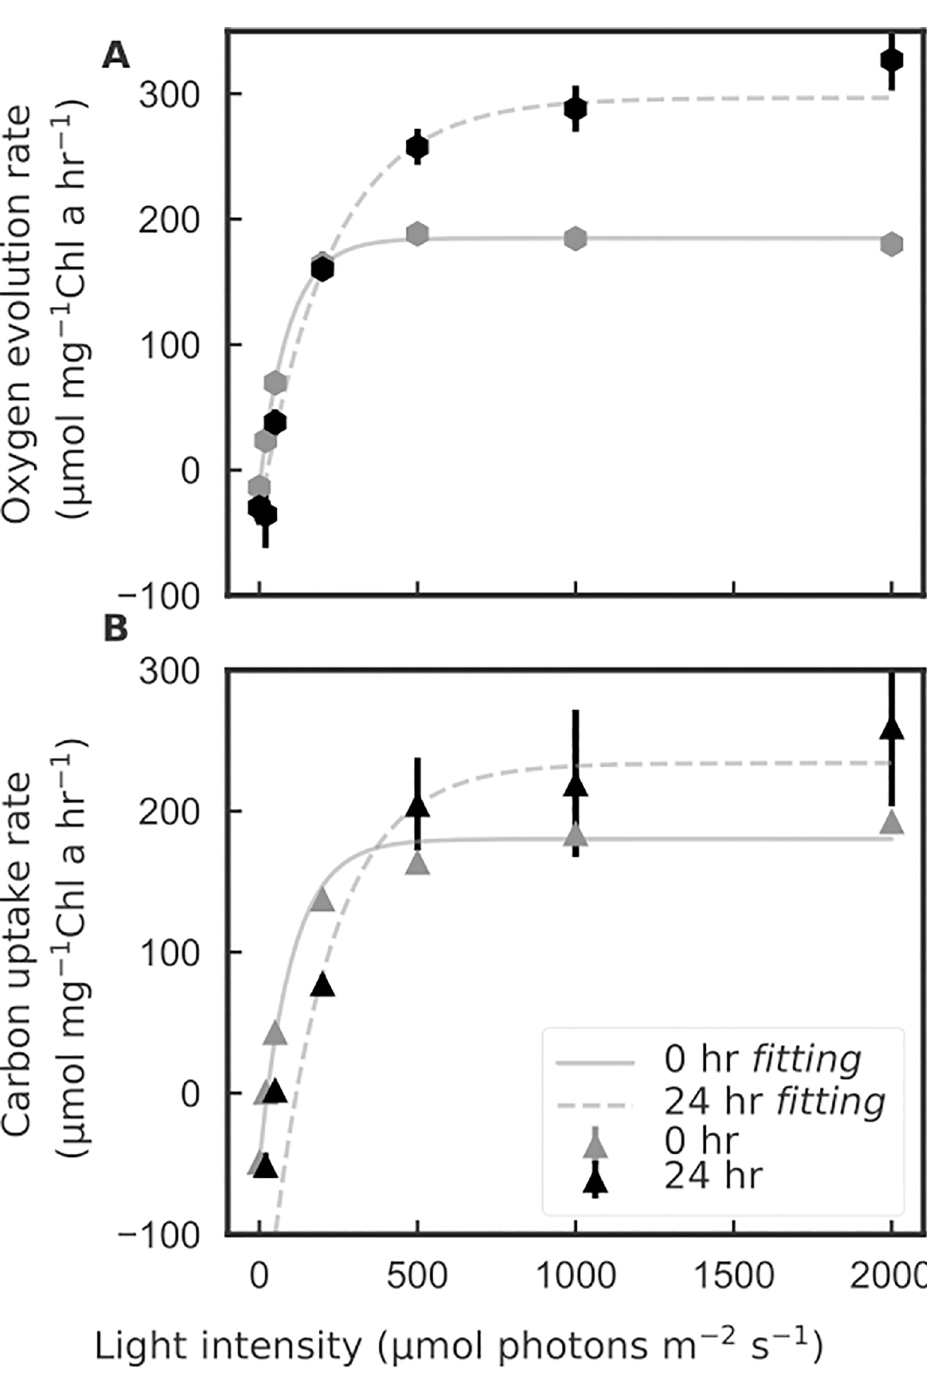
Fig 6. (A) Chlorophyll a specific oxygen evolution, and (B) carbon uptake rates, as a function of light intensities measured with the pHOS-MIMS system at 0 and 24 at the start and end of the 24 hours low-to-high light acclimation. Error bars are standard deviations for n = 3; for values with no error bar shown, the standard deviation was smaller than the symbol in the figure. The initial slopes (μmole carbon or oxygen mg -1 Chla h -1 [μmole quanta m -2 s -1]-1 ) of the fitted curves were determined using equations developed by Jassby and Platt [35] with values as follows: 2.17 for oxygen evolution at 0 hour; 1.46 for oxygen evolution at 24 hours; 2.12 for carbon uptake at 0 hour; 2.36 for carbon uptake at hour 24